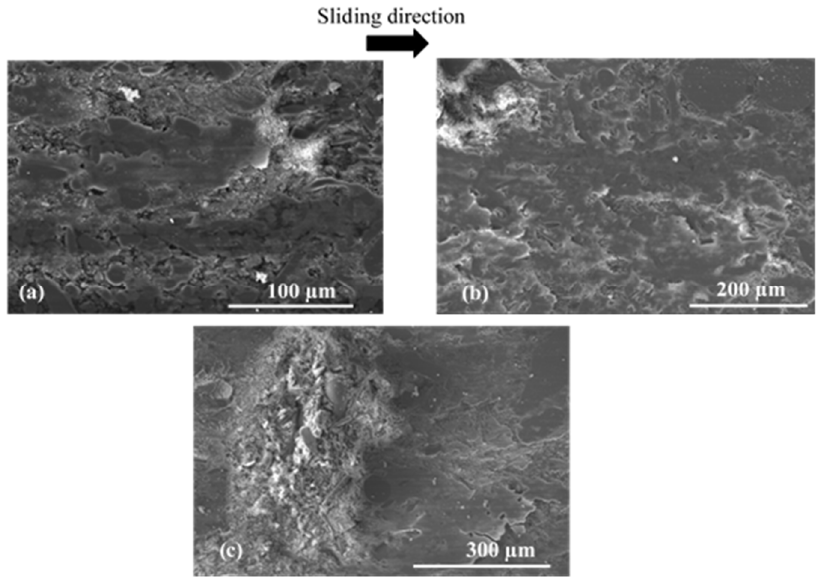
Figure 17. Secondary third-body plateaus located at the load-bearing zone at ( a ) IR, ( b ) AR, and ( c ) OR. ( c ) OR.